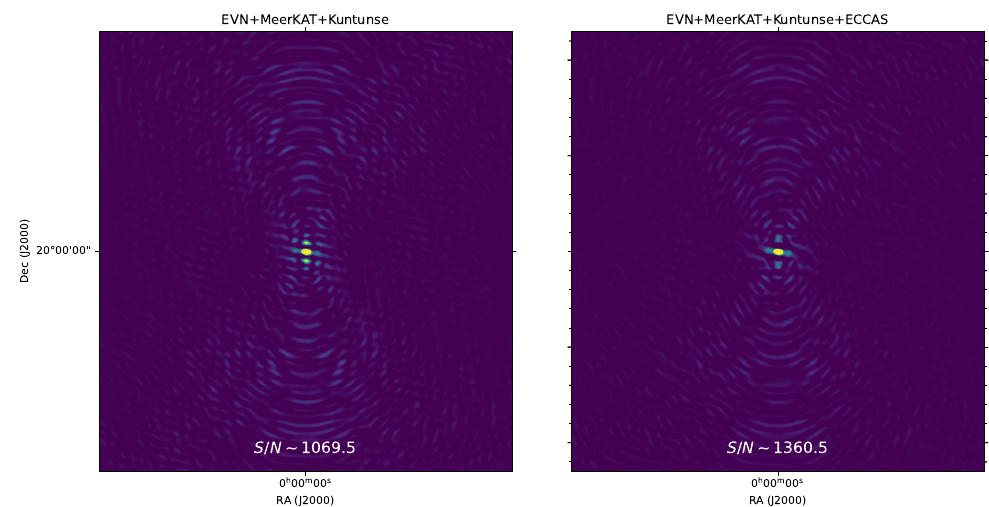
Figure 6. Simulated sky model with two point sources: a 1 Jy point source at the phase centre and a far-field point source with 5 Jy brightness located at 6 arcmin from the phase centre as seen by the EVN + MeerKAT + Kuntunse telescope (left) and by the EVN + MeerKAT + Kuntunse + ECCAS telescope (right) for a simulated observation at 16 GHz. To corrupt the simulation, 1 Jy Gaussian noise per visibility is used. The data are sampled during a total period of 10 h with 1 s integration time and using a total bandwidth of 16 MHz divided into 64 channels. Then, a few pixels are imaged to visualise only the source at the phase centre.